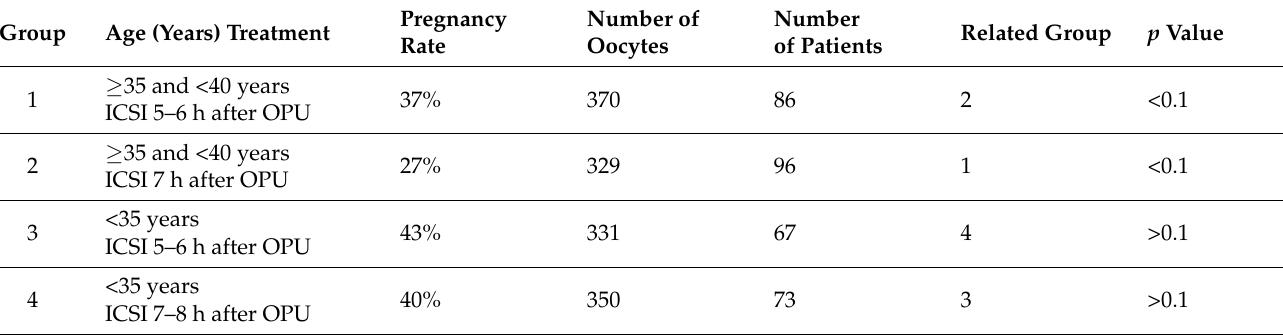
Table 2. Number of pregnant patients, number of their oocytes, and pregnancy rates calculated for groups patients of different age and treated with MS evaluation. The significance values of the difference between pregnancy rates were